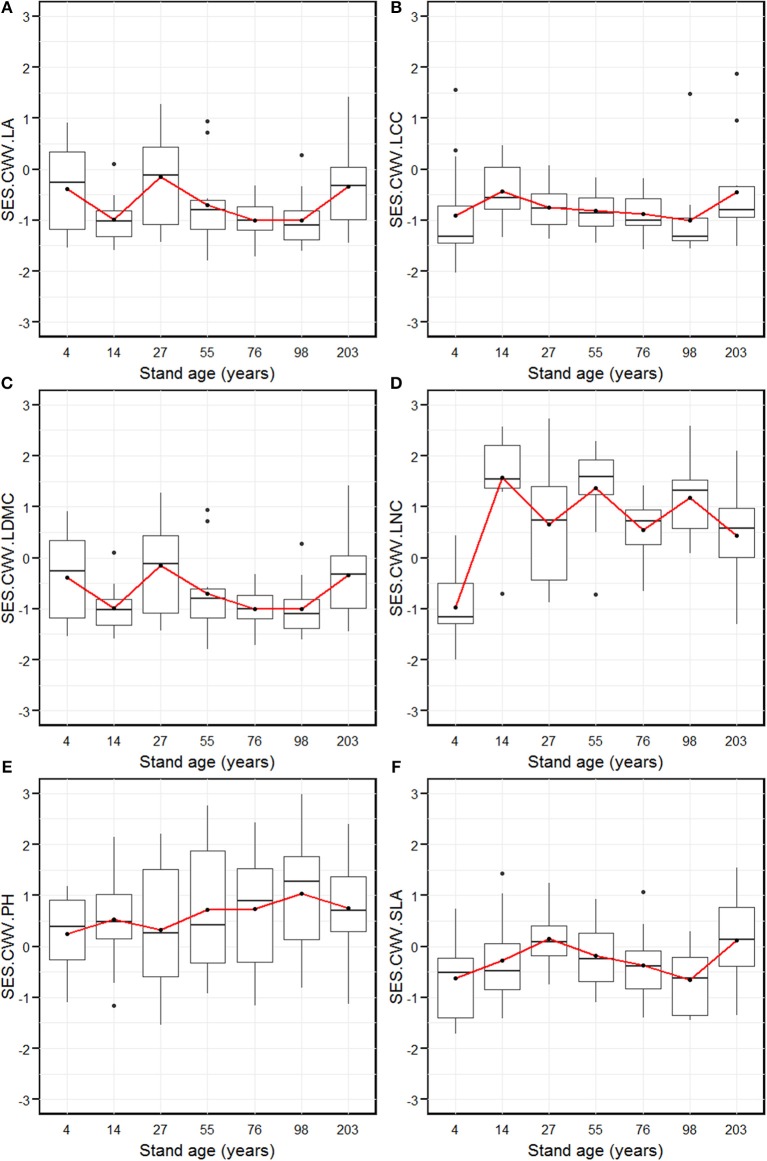
Standardized effect size of community weighted trait variance of leaf area (SES.CWV.LA, A), leaf carbon content (SES.CWV.LCC, B), leaf dry matter content (SES.CWV.LDMC, C), leaf nitrogen content (SES.CWV.LNC, D), plant height (SES.CWV.LA, E), and specific leaf area (SES.CWV.LA, F) along with stand age, which were measured by comparing observed CWV to a null model that was obtained by randomly shuffling the abundance values with unchanged traits. Stand ages from 4 years to 203 years represent early stand initiation, late stand initiation, early stem exclusion, late stem exclusion, early canopy transition, late canopy transition, and gap dynamics stages, respectively. The boxplot midlines correspond to the median value for each stand age; upper and lower hinges represent the first and third quartiles. Letters indicate significant differences of the mean SES values (p < 0.05) across the stand age. Red dots correspond to the SES values at the larger spatial scale by summing the plot composition for each stand age, and asterisks indicate a significant difference from the null model.